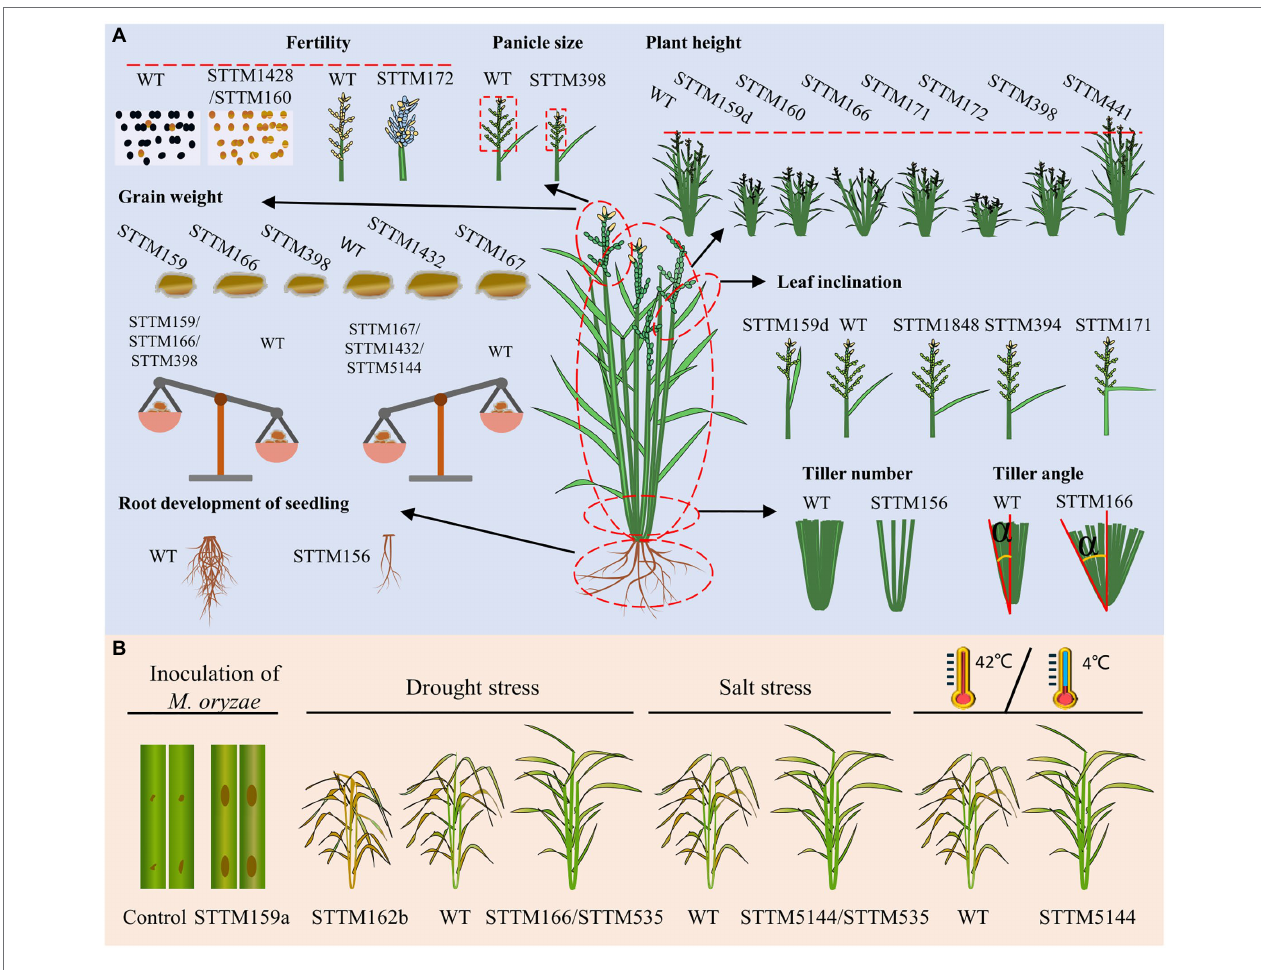
FIGURE 4 | Experimentally verified phenotypes of rice STTM lines: agronomic trait-related (A) and stress response-related (B) . (A) Variations in agronomic traits, including the fertility, panicle size, plant height, grain weight, leaf inclination, tiller number, tiller angle, and root development, of seedlings are diagrammatized. Fertility: fertile (black dots), sterile (yellow dots), filled seeds (yellow grains), empty seeds (blue grains). Grain weight: smaller grains (left side of WT), larger grains (right side of WT), each part of the balance represents the 1,000-grain weight. Leaf inclination: smaller leaf angle (left side of WT), increased leaf angle (right side of WT). (B) Diagrams from left to right represent biotic stress from blast disease caused by Magnaporthe oryzae and abiotic stress, including drought stress, salt stress, high temperature (42 ° C), and low temperature (4 ° C). Brown dots on the leaves indicate disease lesions, deep yellow plants indicate dead tissues and green plants indicate surviving